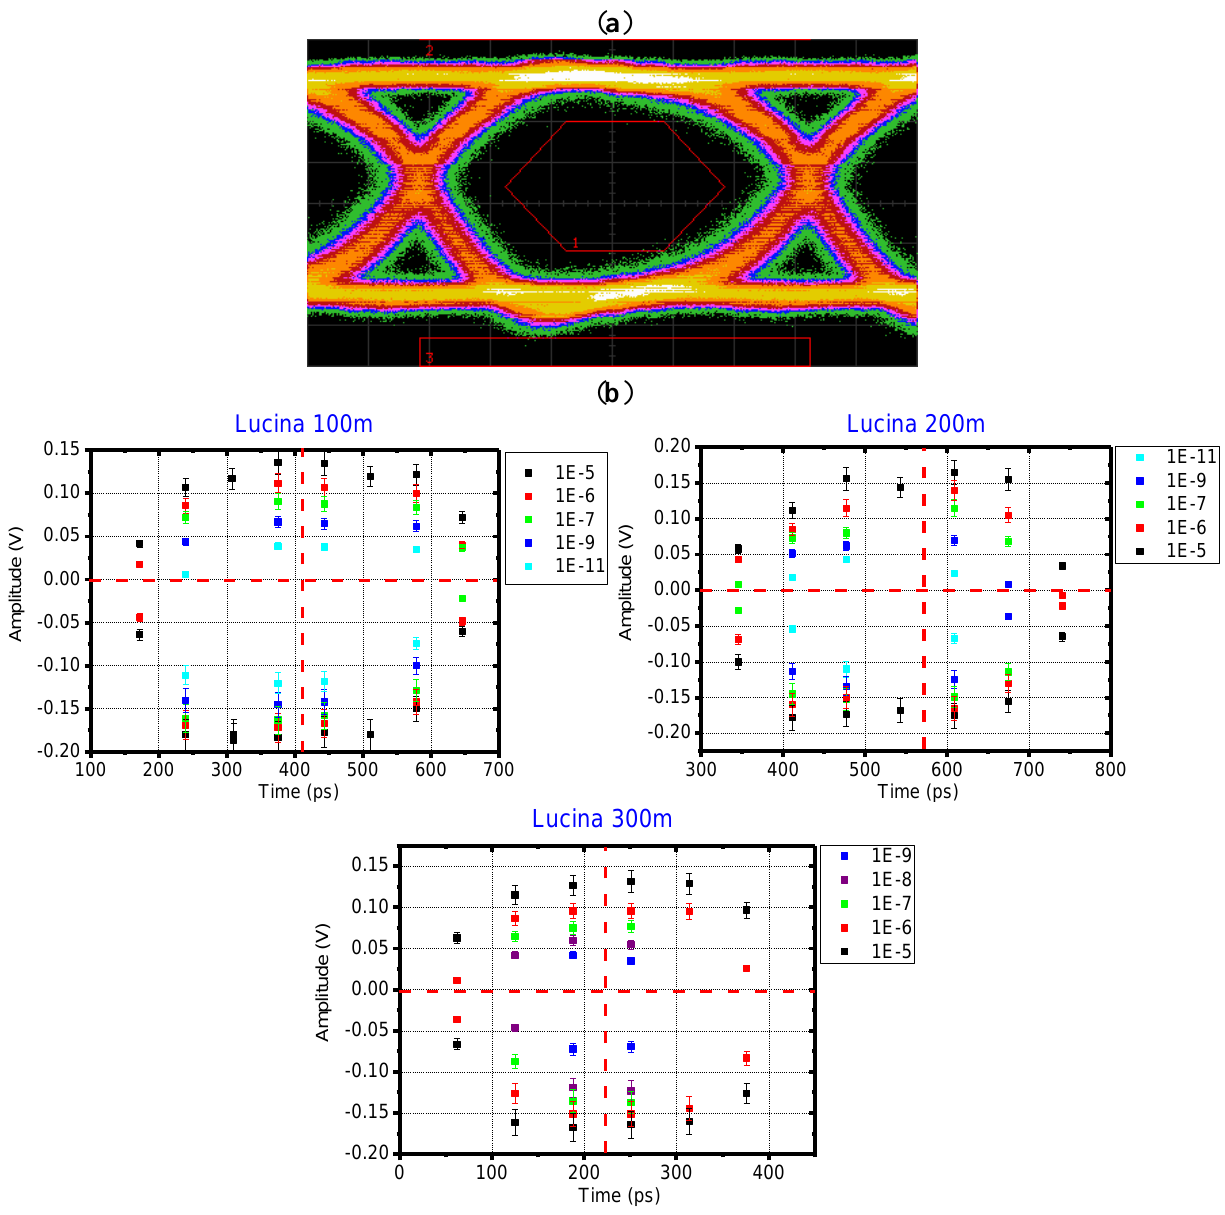
Figure 15. ( a ) Eye diagram of the 1.25 Gbps transmission over 300 m of PFGI-POF. ( b ) IsoBER plot measurement performed at 100 m, 200 m and 300